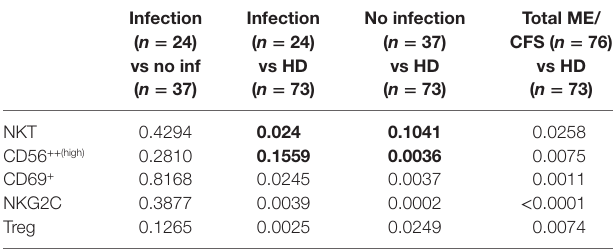
Table 2 | Comparison of differences in the cell phenotypes found to be significantly different (in bold) in myalgic encephalomyelitis/chronic fatigue syndrome (ME/CFS) patients according to the presence or absence of an infectious process as a trigger for the ME/CFS